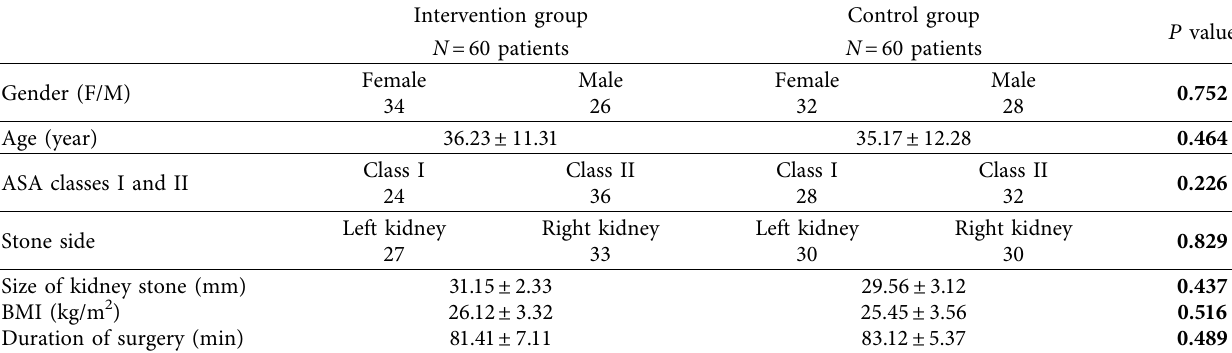
Table 1: Studied patients’ demographic data, size, and location of stones.